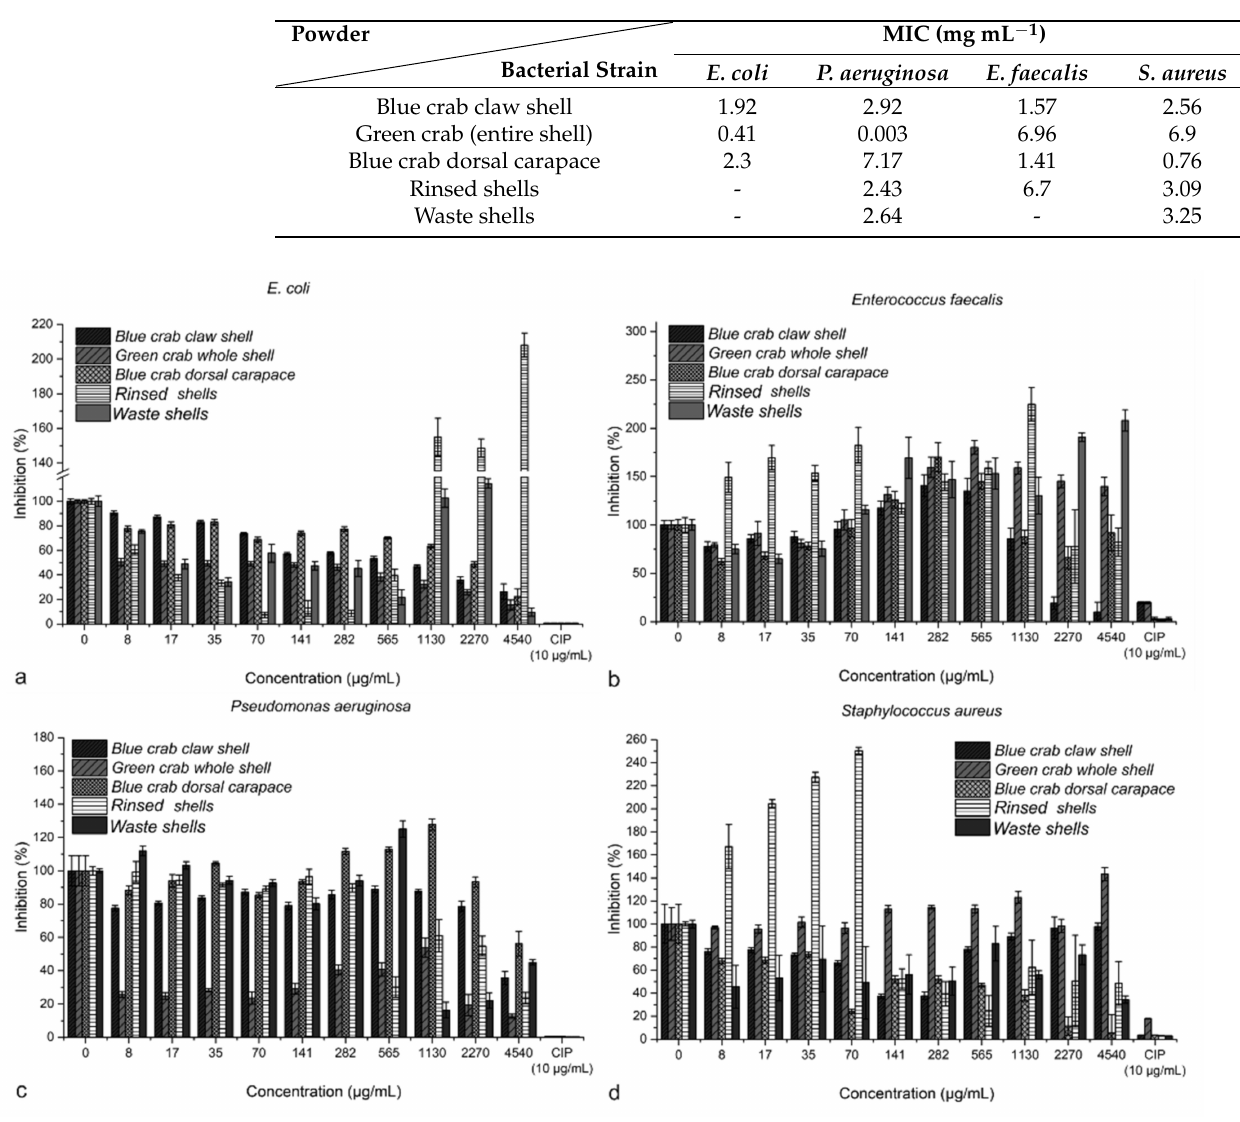
Table 2. The minimal inhibitory concentration (MIC) of crab shell powder determined for each tested bacterial strain.